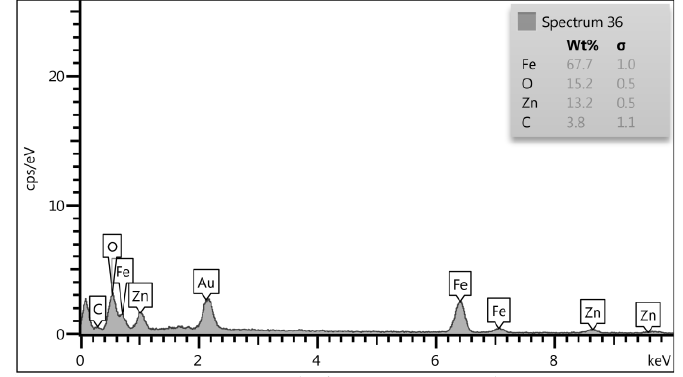
Fig. 4. EDS graph of ZnFe Figure 4 : EDS graph of ZnFe 2 O 4 nanoparticles